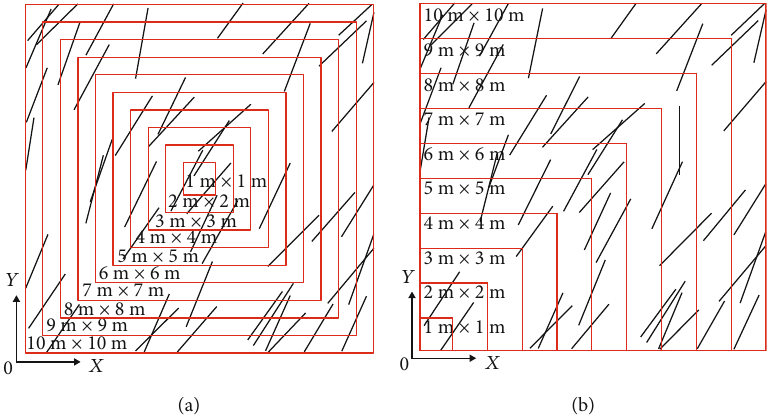
Figure 1: Processive magnifying sampling method: (a) middle ampli fi cation; (b) side ampli fi cation.